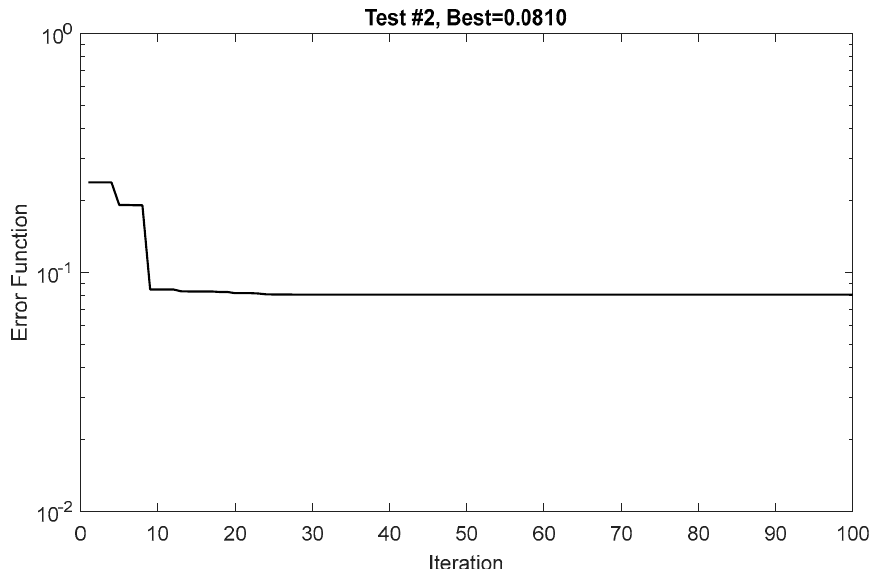
Figure 13. Variation in the error function at each iteration of the Genetic Algorithm in test #2.